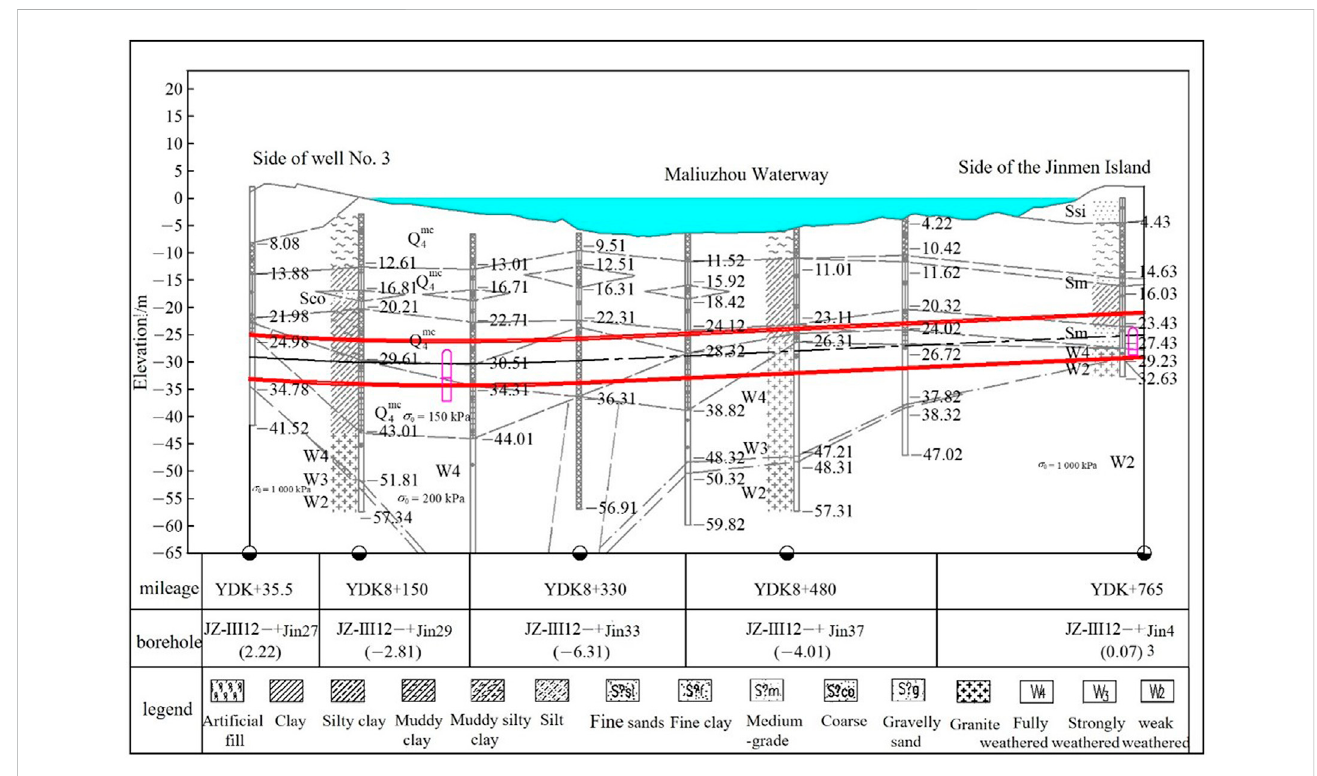
FIGURE 9 Geological section of the construction section of the Hengqin Tunnel passing through the Maciuzhou Waterway.